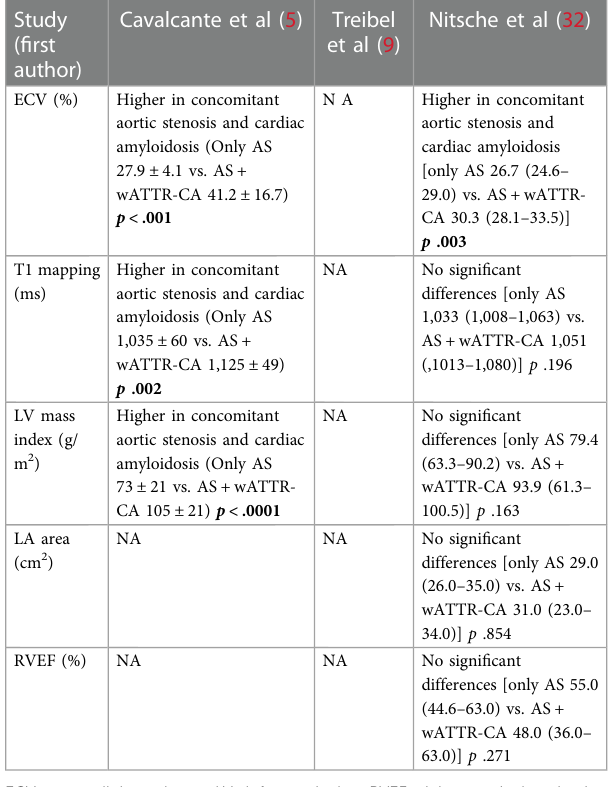
TABLE 4 CMR predictor parameters of concomitant aortic stenosis – cardiac